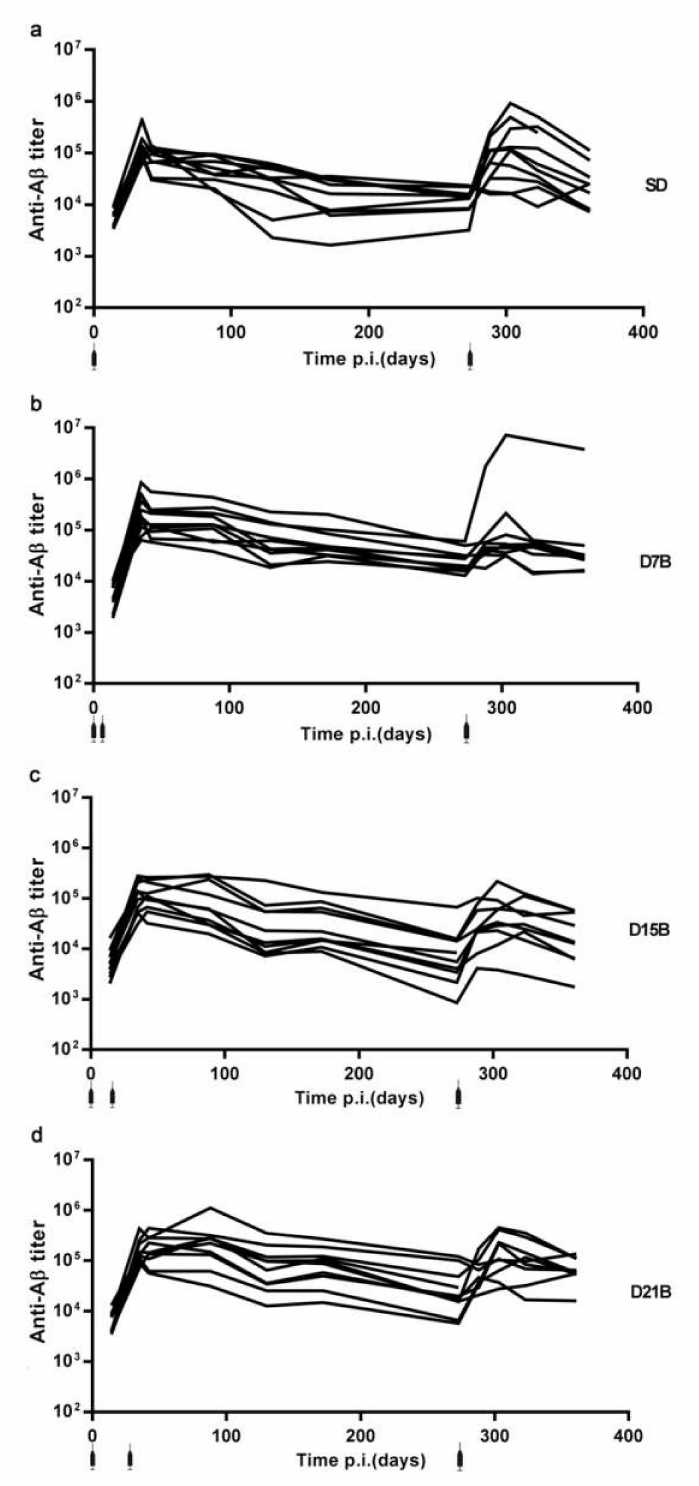
Figure 2. Time course of the IgG titer against A β . The line graphs show the trajectory of the IgG titer in each mouse ( n = 10 per group): ( a ) Control group SD, ( b ) treatment group D7B, ( c ) treatment group D15B, ( d ) treatment group D21B. Injections are shown. Serum was sampled at 9 timepoints: day 14, 35, 42, 88, 273, 288, 302, 323, and